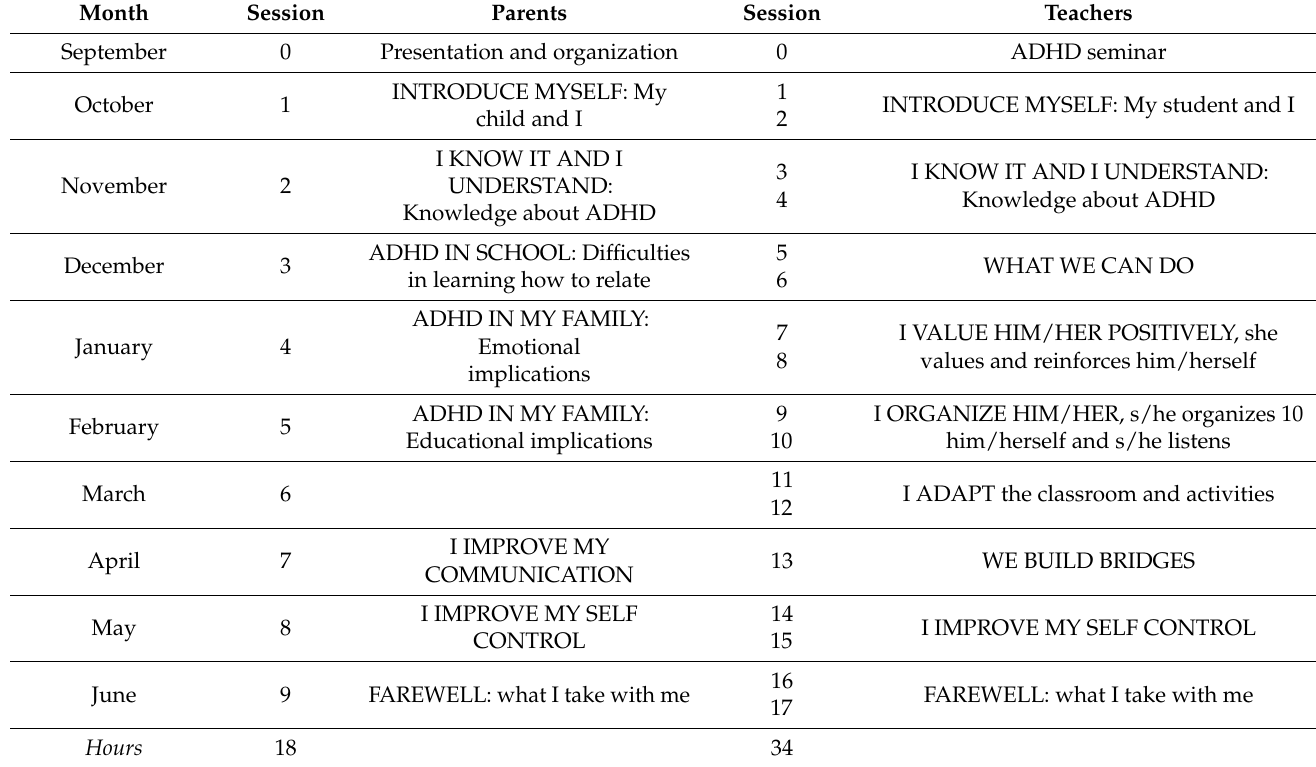
Table 4. Timing of Intervention Developed with Parents and